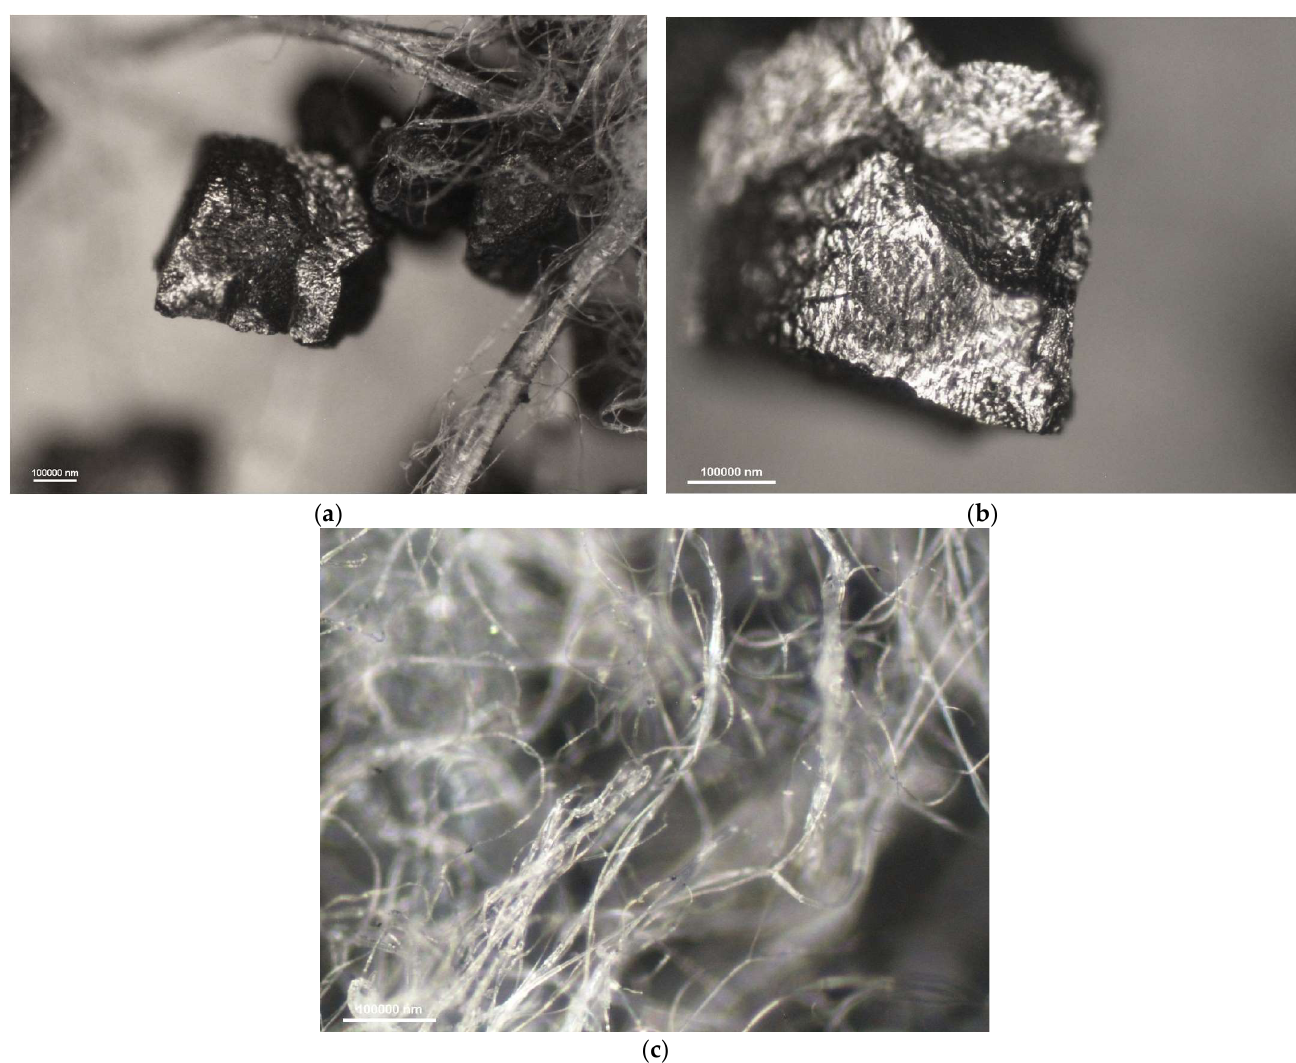
Figure 8. Photomicrographs of adsorbing nonwoven from half-mask 3 at a magnification of ( a ) ×50 and ( b ) ×100; ( c ) outer-layer nonwoven at a magnification of ×50 .